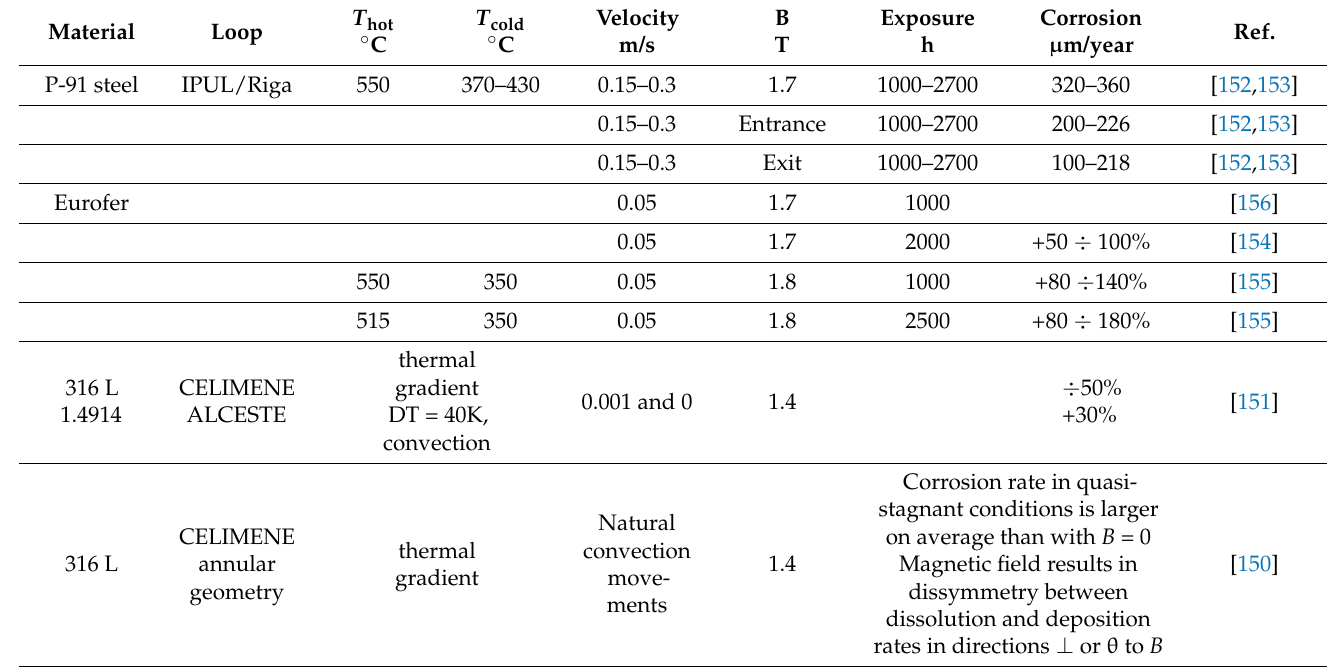
Table 4. Experimental corrosion data of FM steels in flowing PbLi with magnetic